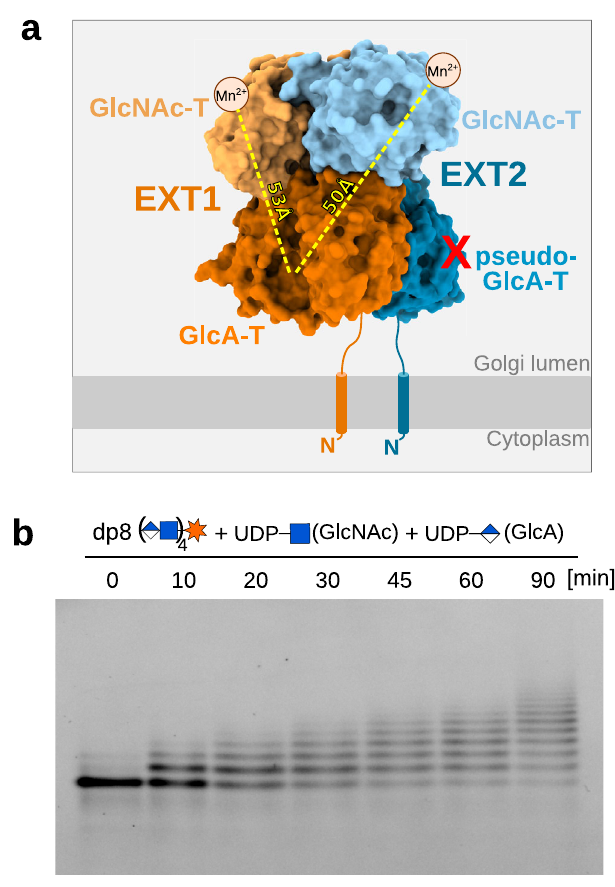
Fig. 5 | Heparan sulfate chain elongation is nonprocessive. a Surface repre- sentation of the EXT1-EXT2 complex. The metal-ion dependence of the GlcNAc-T reaction is indicated by small spheres with a Mn 2+ label. A red cross illustrates that thepseudo-GlcA-TdomainofEXT2iscatalyticinactive.DistancesbetweentheEXT1 GlcA-T active site and the GlcNAc-T active sites of EXT1 and EXT2 are marked by a yellow dotted line. b Time course experiment using an excess of fl uorescently- labeled oligosaccharide (dp8) substrate and limiting amounts of puri fi ed EXT1- EXT2complex.Aladder-likepatternsuggeststhatGlcNAcandGlcAadditionbythe EXT1-EXT2 complex occur in a step-wise fashion. Source data is provided as a Source Data 7. GlcNAc-T, N -Acetylglucosamine-transferase; GlcA-T, glucuronic